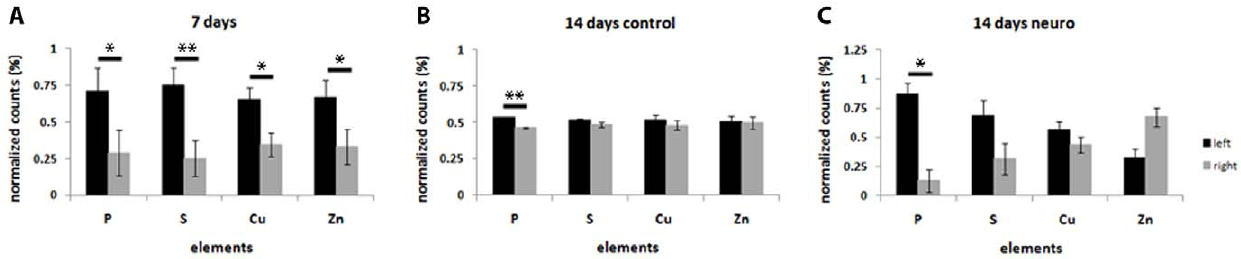
Figure 10. Human pluripotent cells-derived embryoid bodies retain P and S polarization under neural stimulus. Left and right intensity of P, S, Cu and Zn in H9 embryoid bodies. A) 7 days old group; B) 14 days old control group; C) 14 days old neural induced group. Black bars correspond to the left side, grey bars correspond to the right side of atomic maps, *p , 0.05 and **p , 0.01.